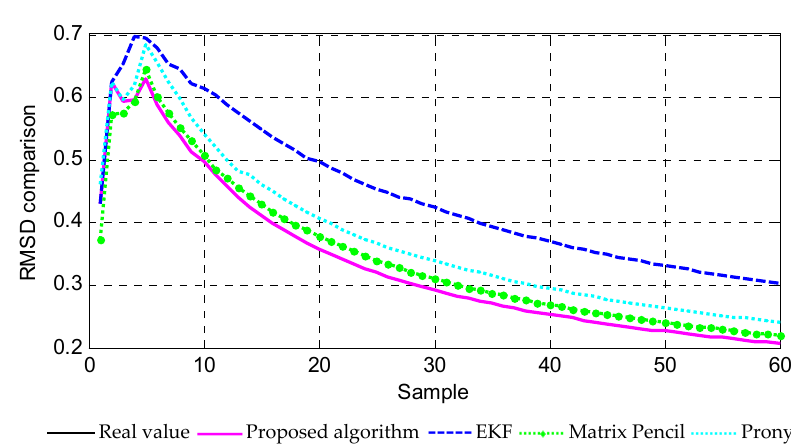
Figure 2. Estimation of ω 1 , δ 1 by using different methods.